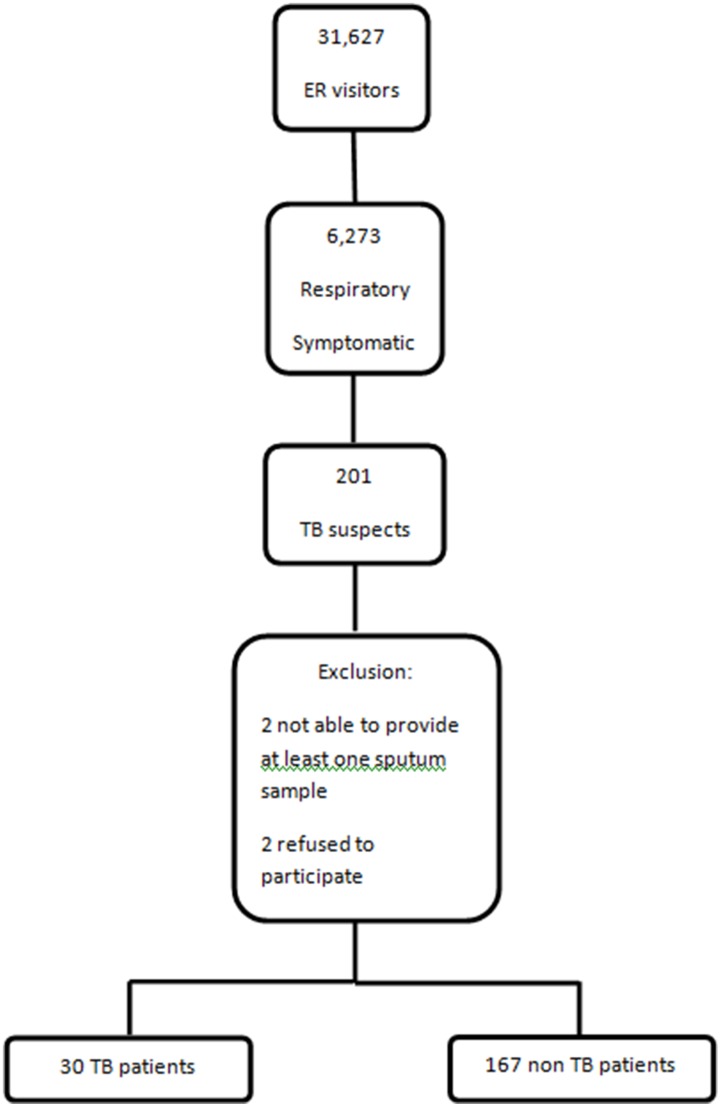
Study flow chart.